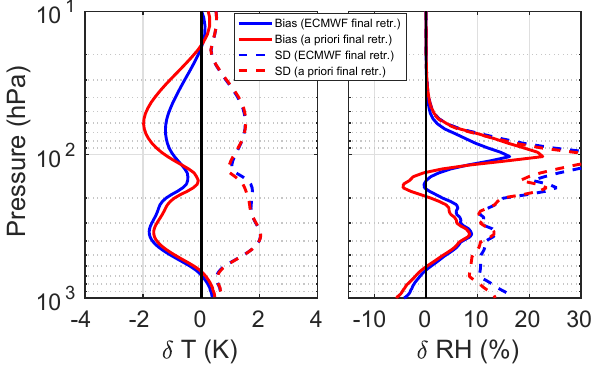
Figure 13. Retrieval statistics for Granule 039 for thick clouds, defined by the number of DOFs to be < 7. Comparisons between ECMWF profiles (multiplied by averaging kernels) and our re- trievals in blue, compared to a priori profiles (multiplied by aver- aging kernels) and our retrievals in red. The solids are the mean differences while the dashed are the standard deviations of the dif- ferences. Note that the results from our retrieval used over 95% of scenes in the granule while AIRS L2 had a 60% yield of good or best QA down to the surface; the intersection here is 77 pro- files. Very similar plots are obtained if we use all 1592 low-DOF